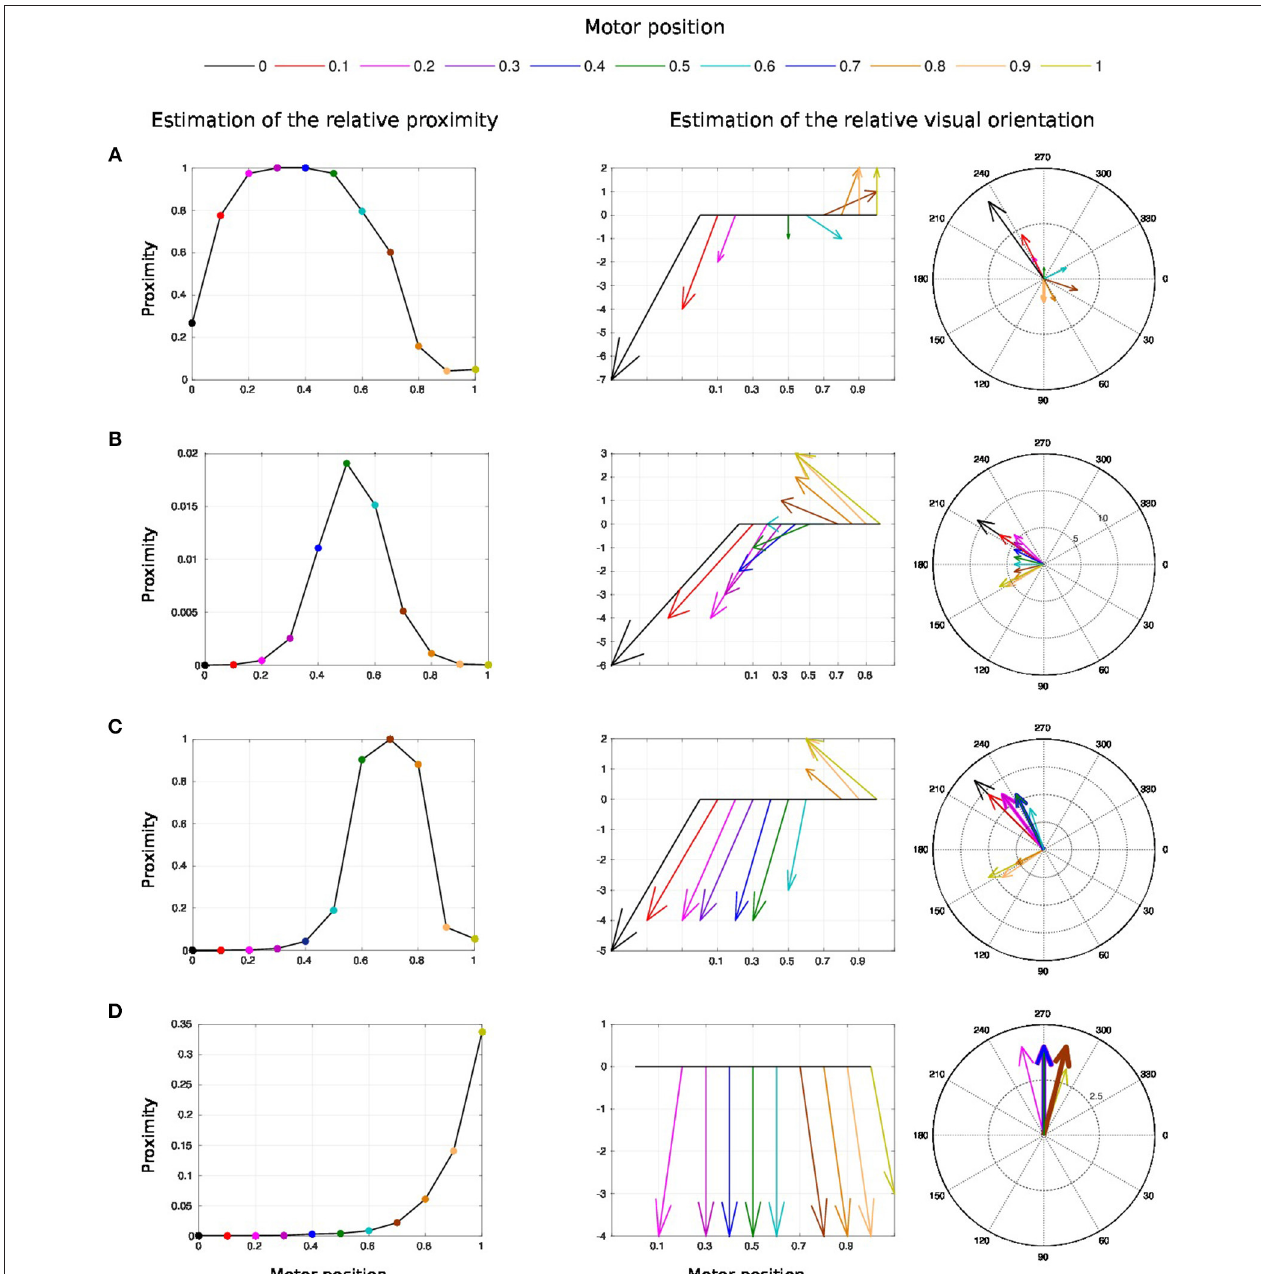
FIGURE 11 | Spatial receptive fields and relative visual orientation of target-centered GF neurons. The left charts correspond to the estimated proximity of the four GF neurons target centered at fixed positions respectively at locations (A–D) . The y axis corresponds to amplitude level of the neurons whereas the x axis and the color code represent the different motor positions between [0 and 100 ◦ ] and normalized between [0 and 1]. Location A is the nearest to the arm and location D is the farthest. Each target-centered neuron show different types of receptive field with respect to the distance to the arm. The higher the amplitude level is, the closer the arm is with respect to the target. When the amplitude level reaches 1, it indicates that the target is above the arm in the visual space. The middle and right charts represent the estimated relative visual orientation between the target and the robot arm. The middle plot displays orientation vectors coming from equally spaced points along a horizontal axis. It expresses the orientation vector components relative to the origin of the respective orientation vector. The x-axis and the color code represent the different motor positions, the arrows’ length corresponds to the amplitude level of the neurons, i.e., the proximity of the RF, and their orientation corresponds to the orientation. The y-axis represents the y components in relative coordinates. The right chart presents the same information in polar coordinates centered at the target location.